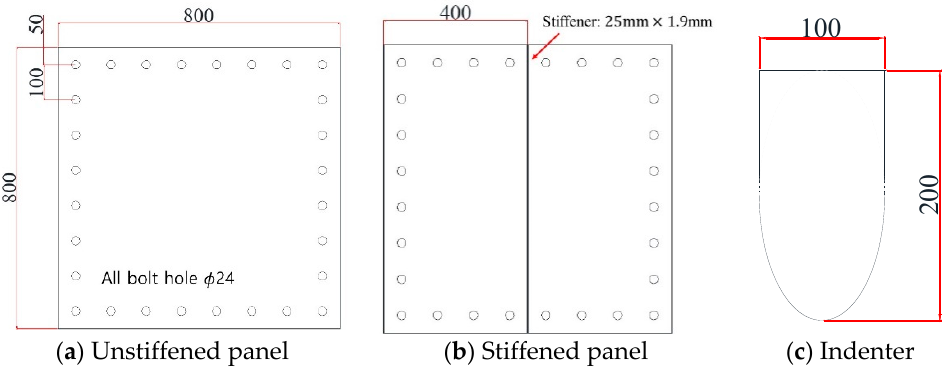
Figure 12. Dimensions of the specimens and indenter (unit: mm).